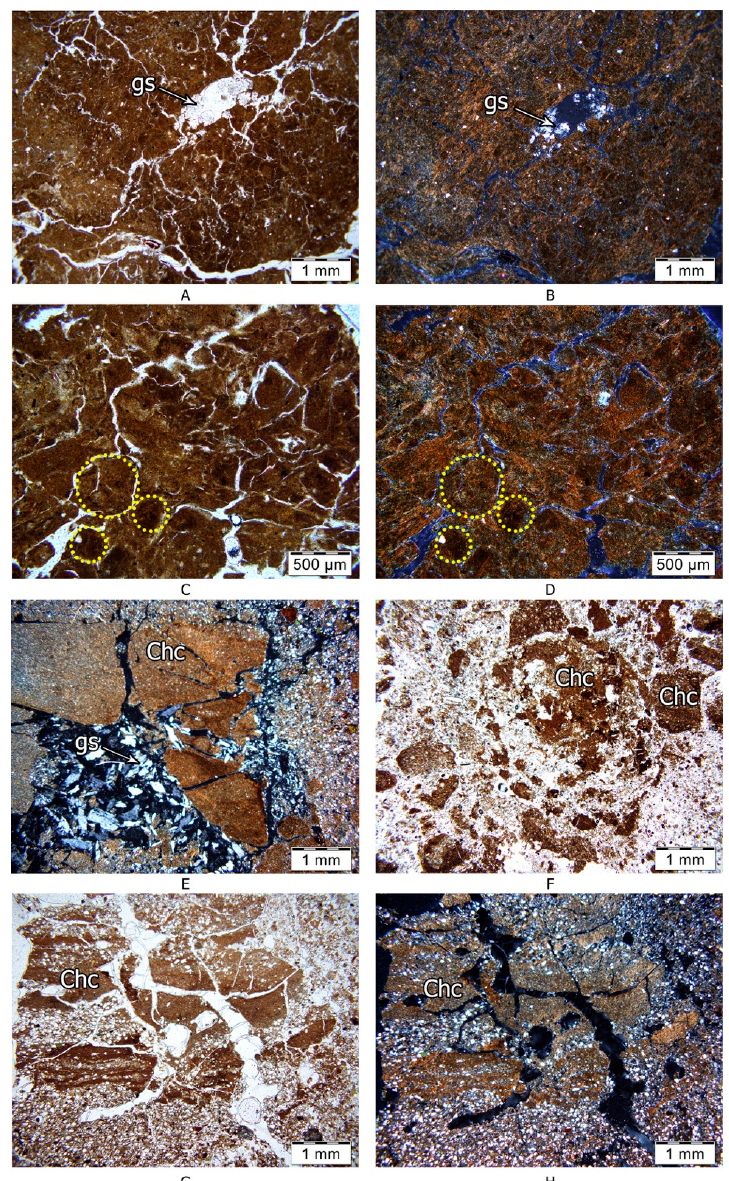
Figure 6. Sub-areal transformation of Chocolate clays. ( A , B )—high birefringence and monostriated b-fabric of the micromass, granular microstructure, and gypsum crystals(gs) in pores (155 cm; ( A )—PPL; ( B )—XPL); ( C , D )—rounded biogenic aggregates (155 cm; ( C )—PPL, ( D )—XPL); ( E )—heterogeneous fragments of Chocolate clays(Chc), splitting of clay plates by gypsum(gs) crystals (100–148 cm, XPL); ( F )—biotubula with fragments of Chocolate clays(Chc) (100–148 cm, PPL); ( G , H )—fragmented plates of Chocolate clays, disintegrated by biogenic pores, in sorted silty micromass (100–148 cm, ( G )—PPL; ( H )–XPL).